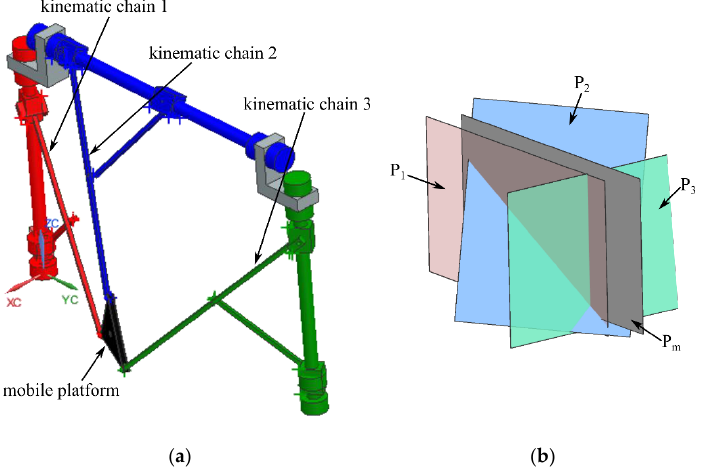
Figure 11. Type II singularity of the 6-DOF parallel robot for SILS (case 5 — one face and the base of the characteristic tetrahedron are coplanar): ( a ) parallel robot pose; ( b ) P 1 and P m are coplanar. In Case 6, two sides and the base of the characteristic tetrahedron are coplanar [30]. For